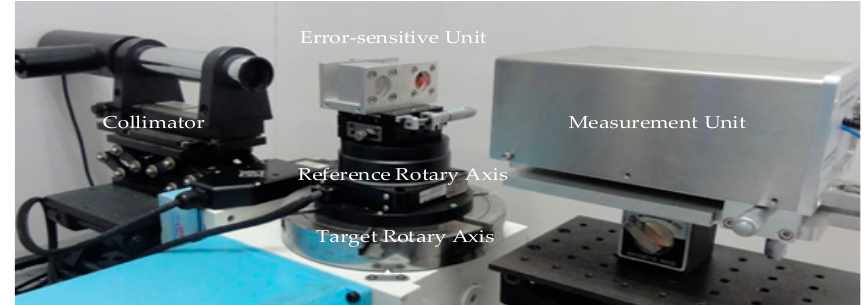
Figure 5. Measurement device.